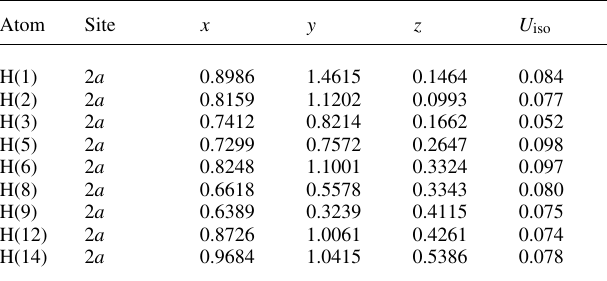
Table 2. Atomic coordinates and displacement parameters (in Å 2 ) .